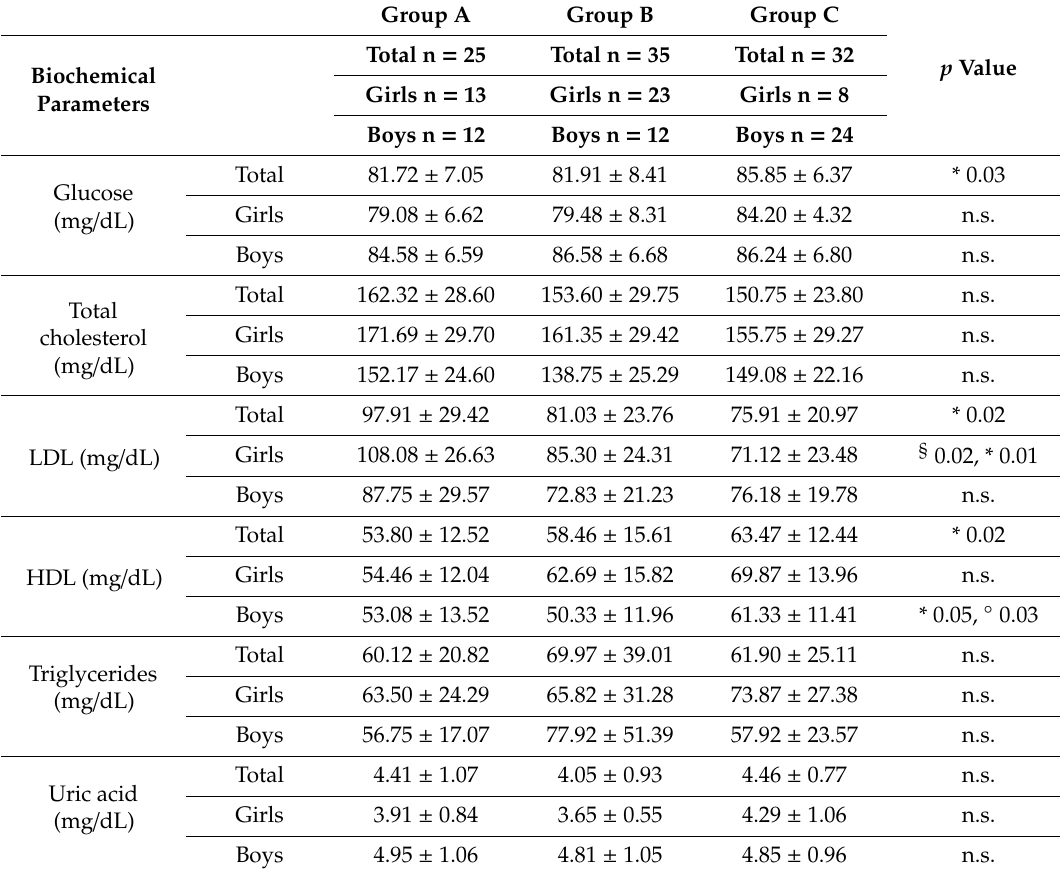
Table 3. Biochemical parameters, hormonal serum levels, and Mediterranean diet adherence (KIDMED) according to three physical activity groups in all the sample and di ff erentiated by